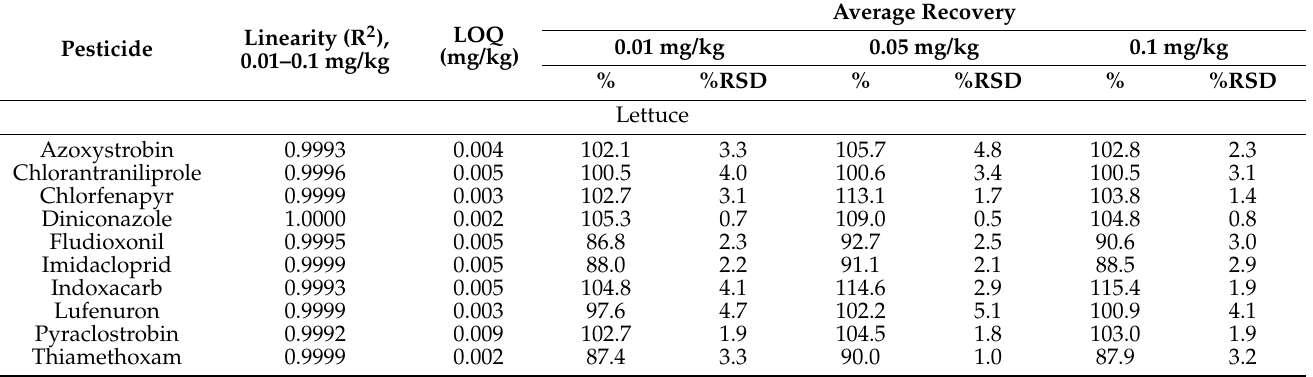
Table 3. Regression coefficient (R 2 ), LOQs, and average recoveries for ten pesticides in five leafy vegetables (n =